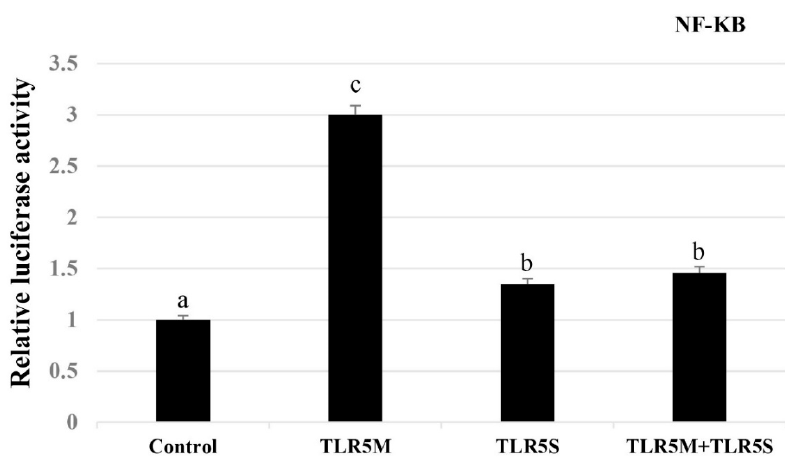
Figure 7. Overexpression of two ToTLR5 genes altered the expression levels of NF- κ B. The cells were transfected with an empty vector or ToTLR5s -pcDNA3.1. Each of them was co-transfected with an NF- κ B reporter plasmid. All data are expressed as mean ± SE. Different letters show significant differences ( p < 0.05).